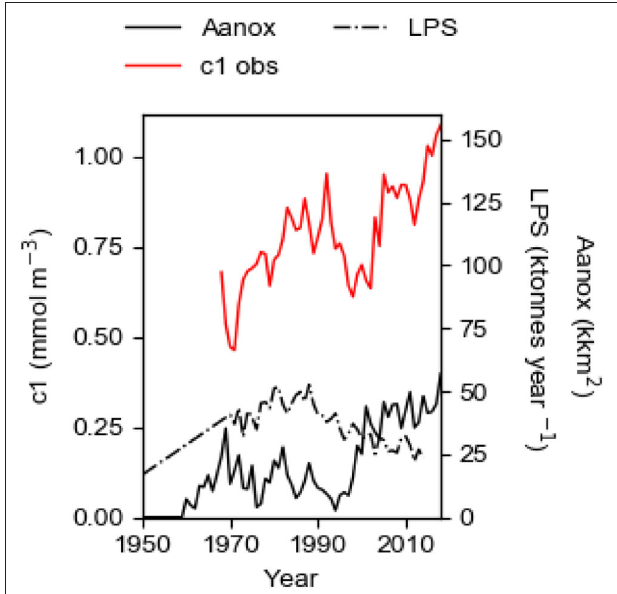
FIGURE 1 | The observed winter surface concentration c1 ( c1obs ) in the 60m thick surface layer of the Baltic proper 1968–2018; the land-based P source LPS 1950–2014; the area Aanox of anoxic bottoms 1950–2018. Data are described in the section Data.